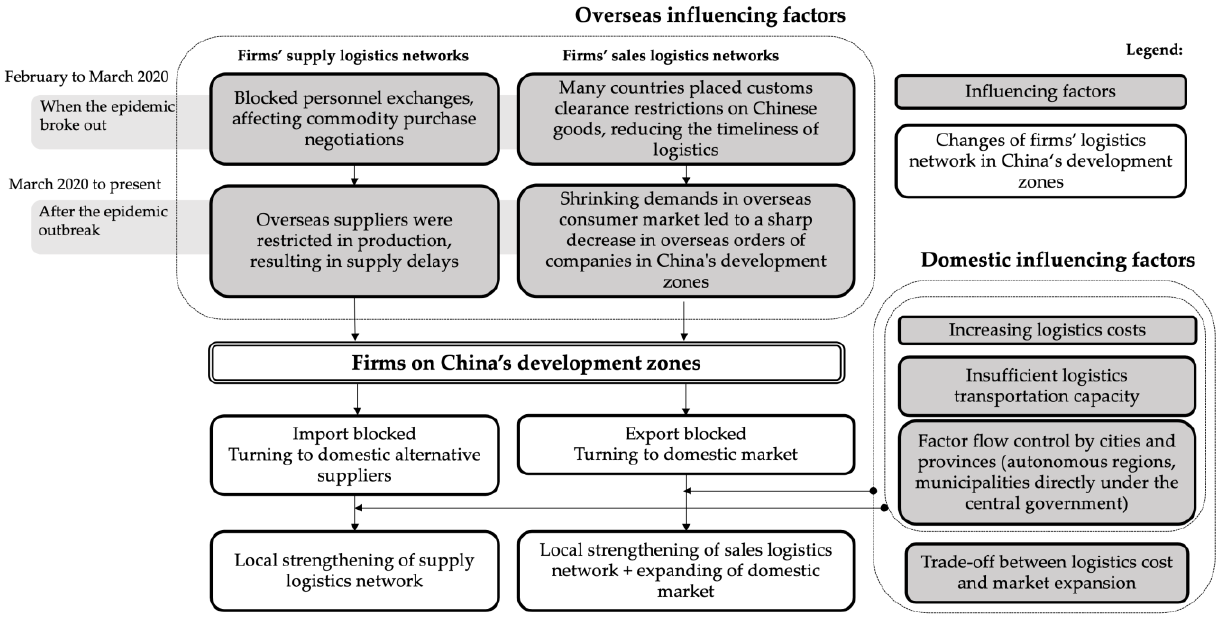
Figure 10. Changes to, and influencing factors of, firms’ logistics networks in the development zones after the outbreak of the pandemic.